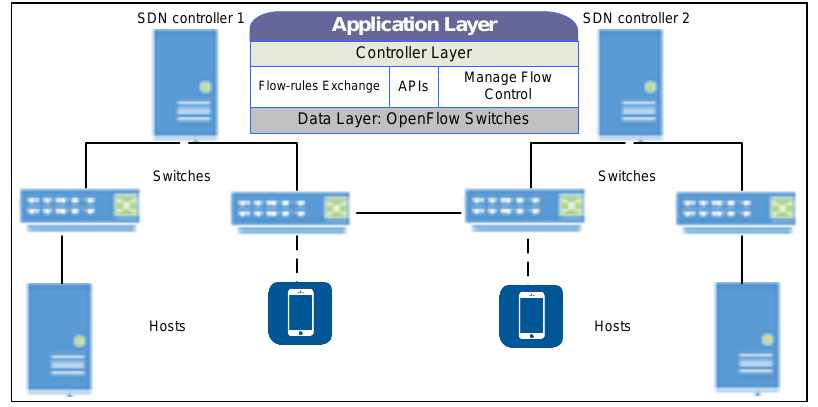
Figure 3. Flow-rule exchanger.